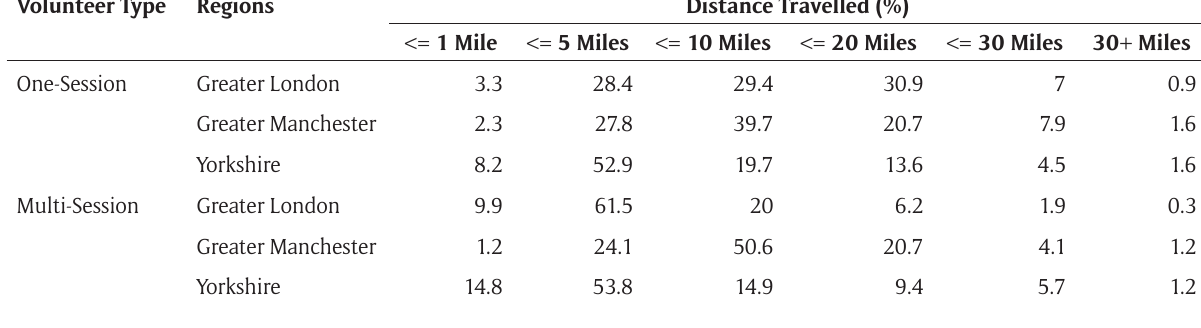
Table 4: General descriptions for each of the engagement characteristics (Activity Ratio [AR], Relative Activity Duration [RAD], Variation in Periodicity [VP], and Distance Travelled in miles [Distance]) compared across each region.